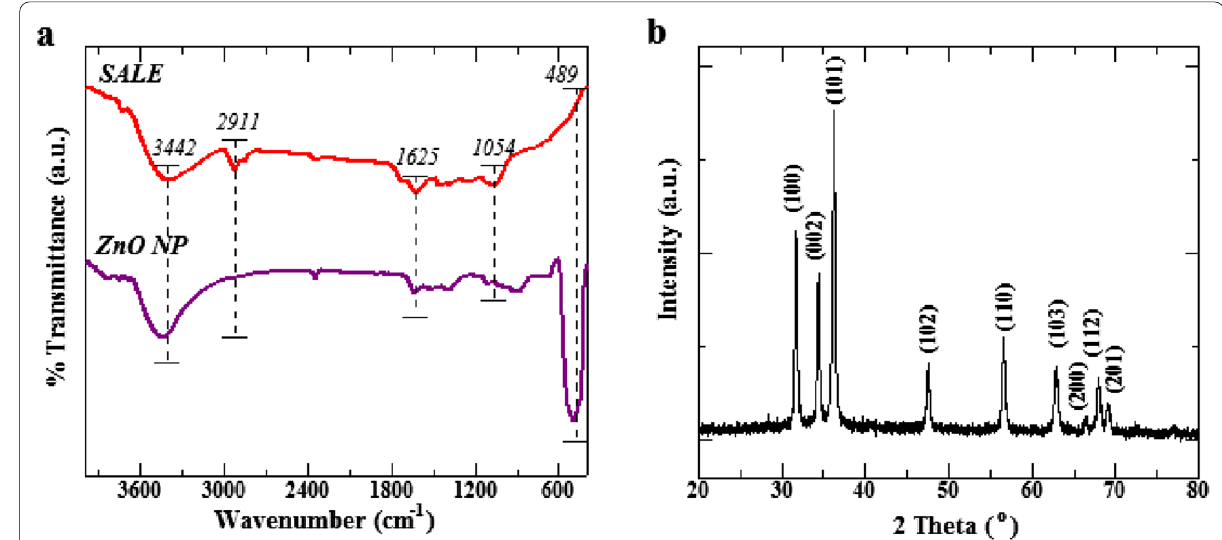
Fig. 1 a FTIR spectra of ZnO NPs in comparison with SALE b XRD pattern of ZnO